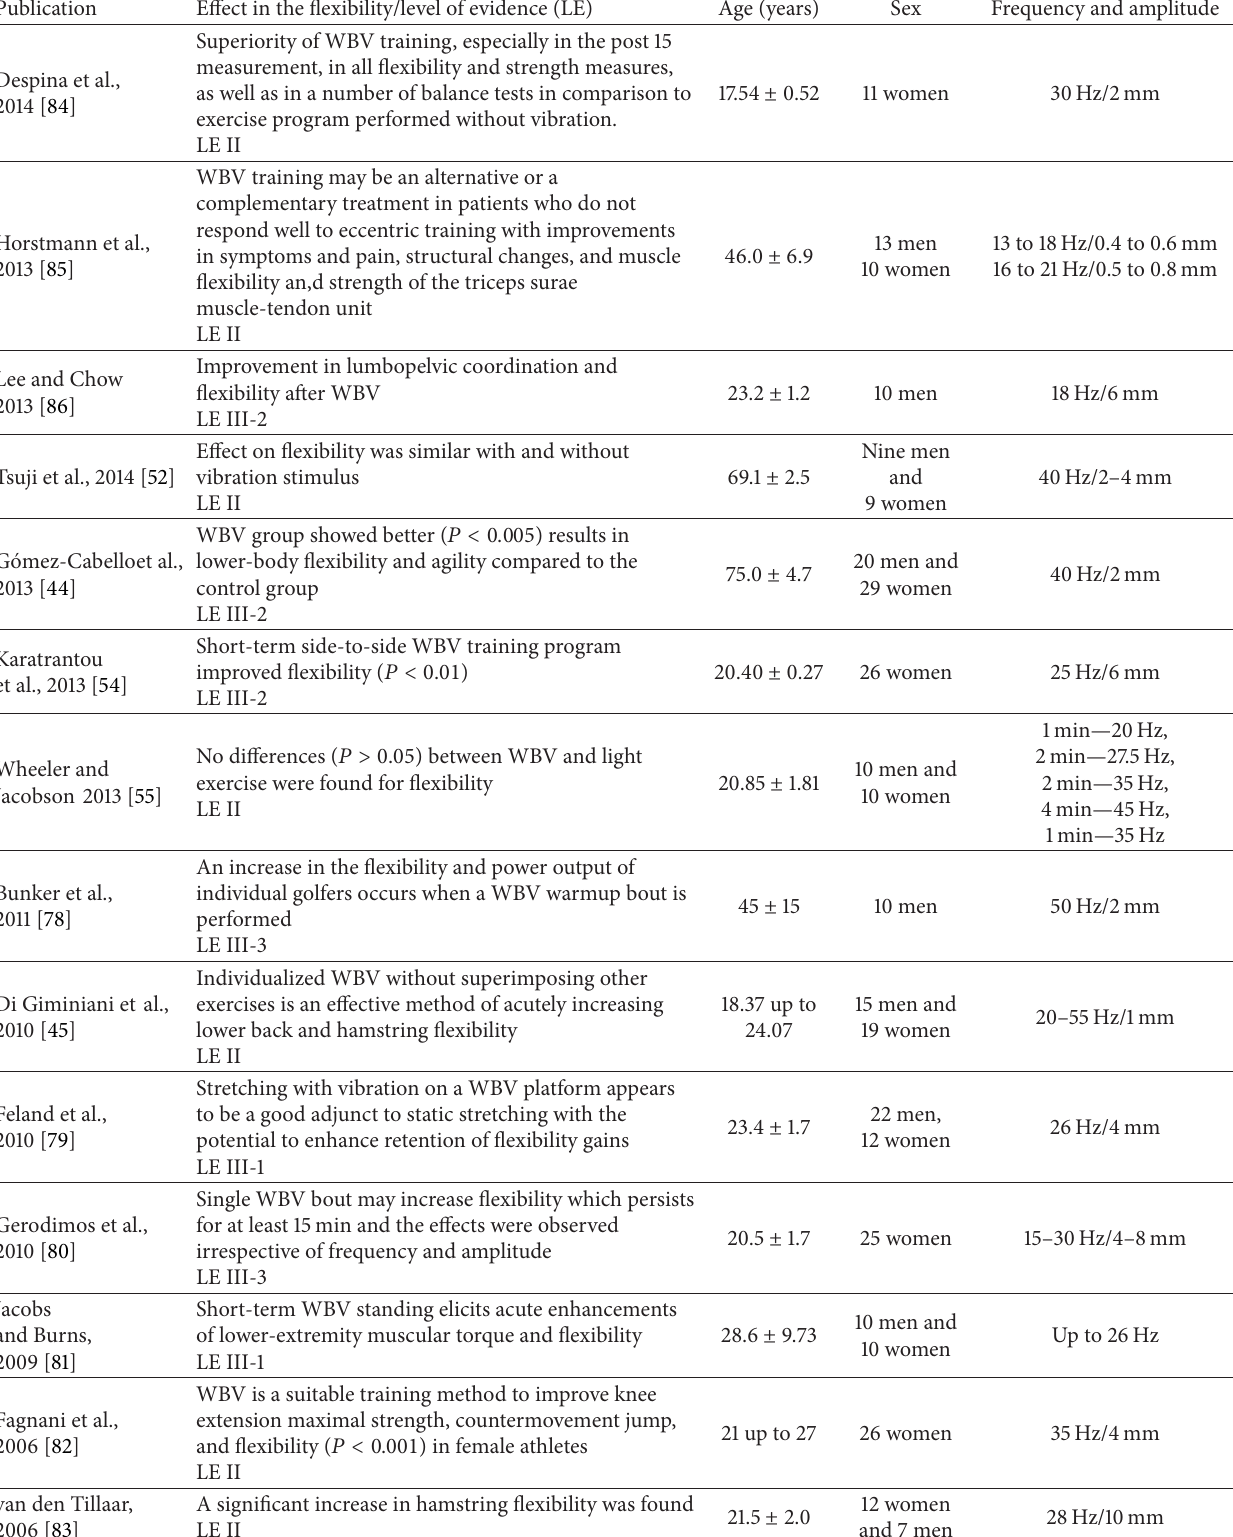
Table 2: Findings about the effect of the WBV in the flexibility, the frequency used, and the mean age and sex of the subjects in the selected